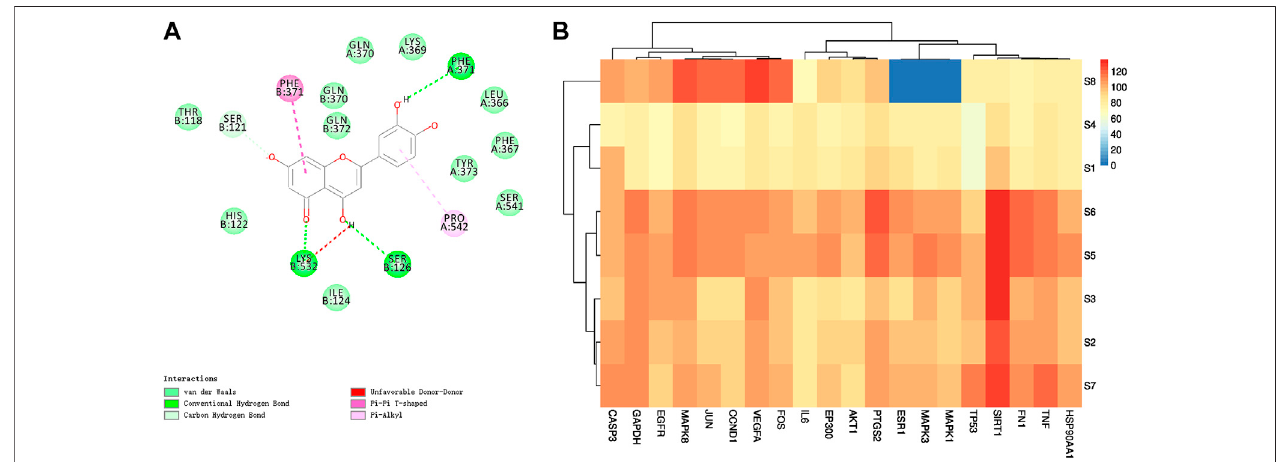
FIGURE 12 | (A) 2D graph of luteolin and PTGS2 molecular docking results (B) Heatmap of molecular docking scores of core ingredients and core targets. S1: ferulic acid; S2: apigenin; S3: kaempferol; S4: caffeic acid; S5: methyl linolenate; S6: linoleic acid; S7: luteolin; S8: robinin.